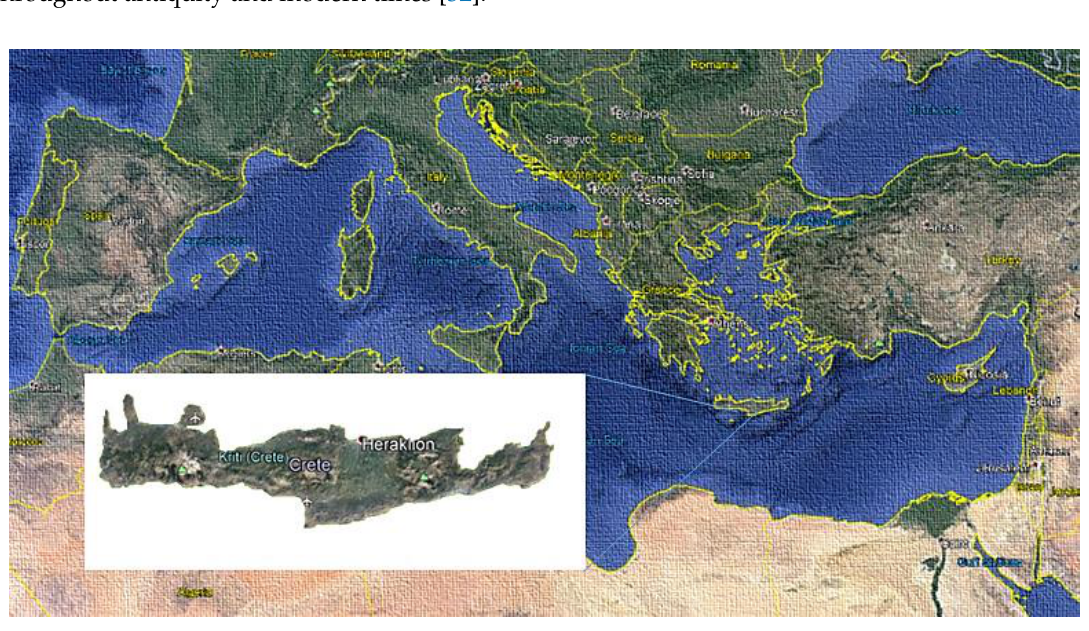
Figure 1. The location of Crete (Google earth, 2019).